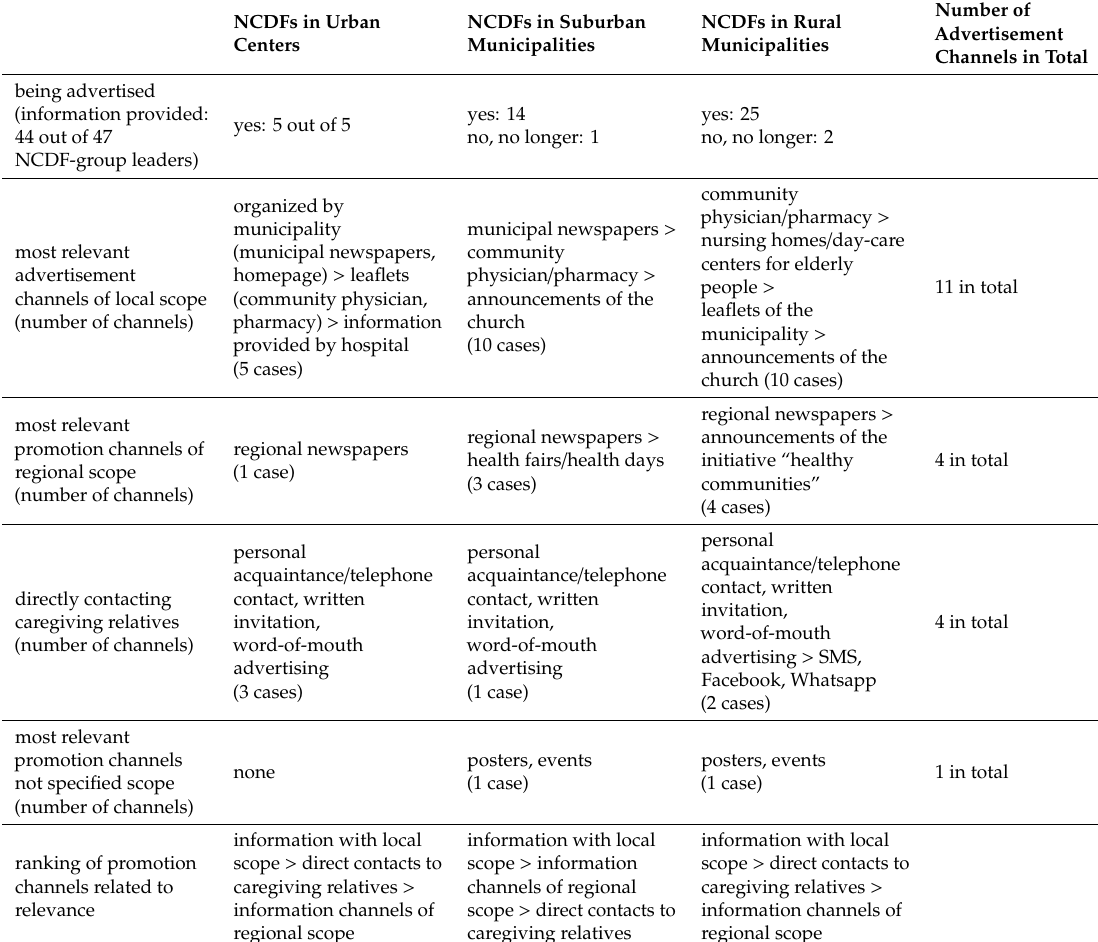
Table 6. Advertising